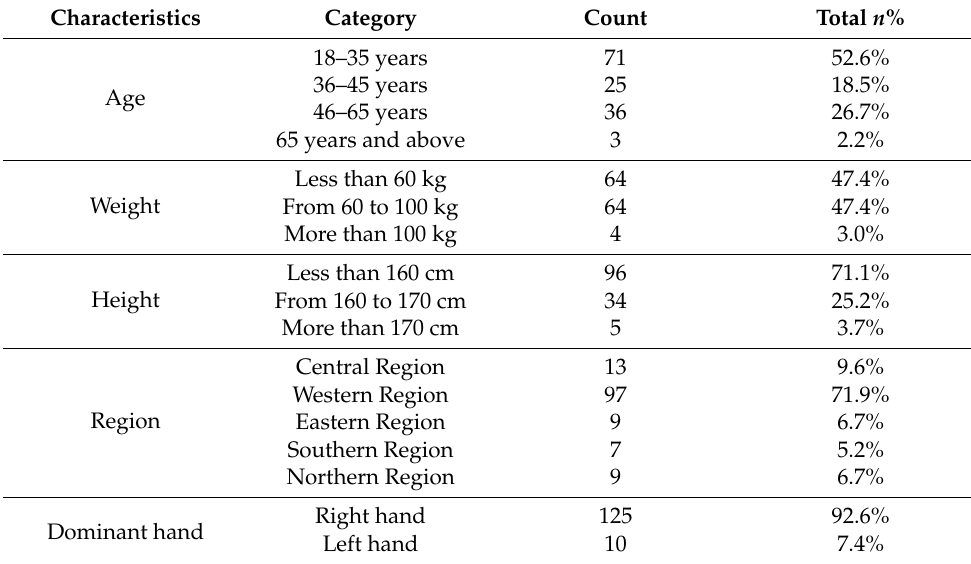
Table 1. Percentage and frequency allocation of the study sample by their sociodemographic charac- teristics ( n = 135).